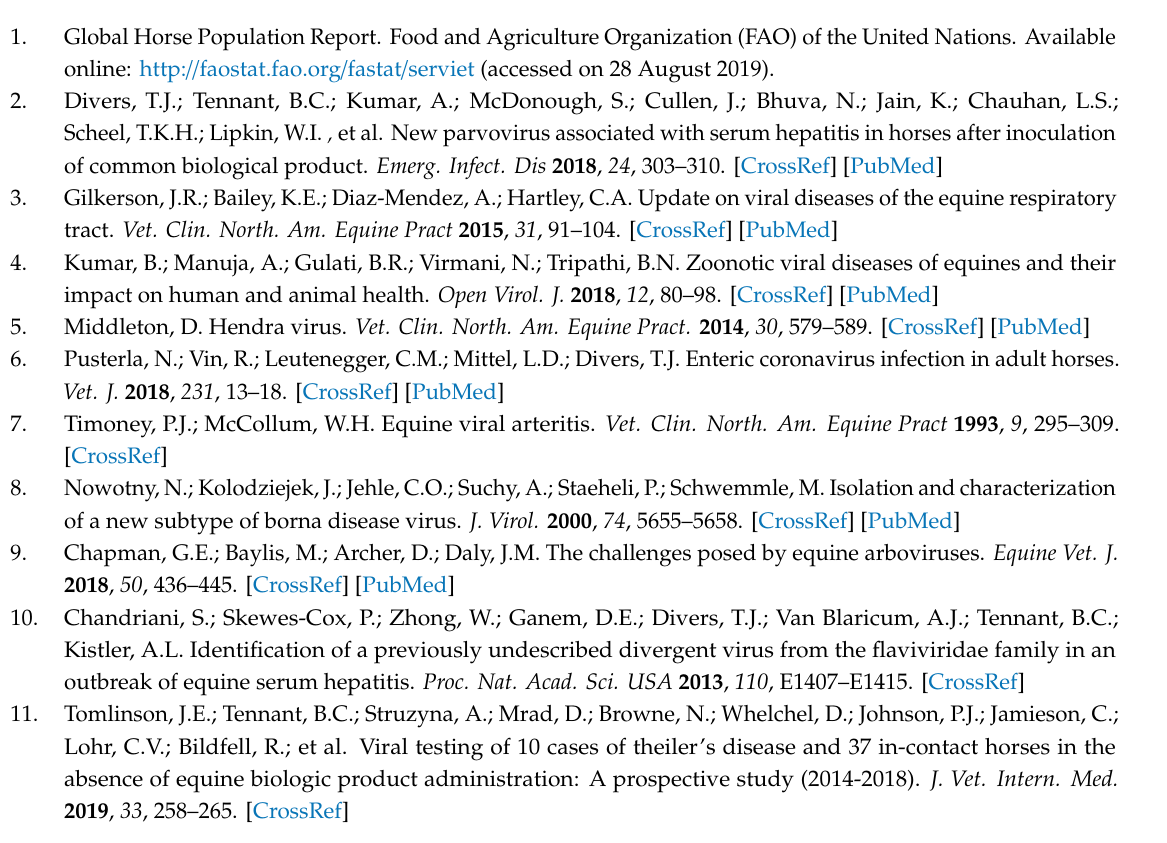
Table S1: Real time PCR